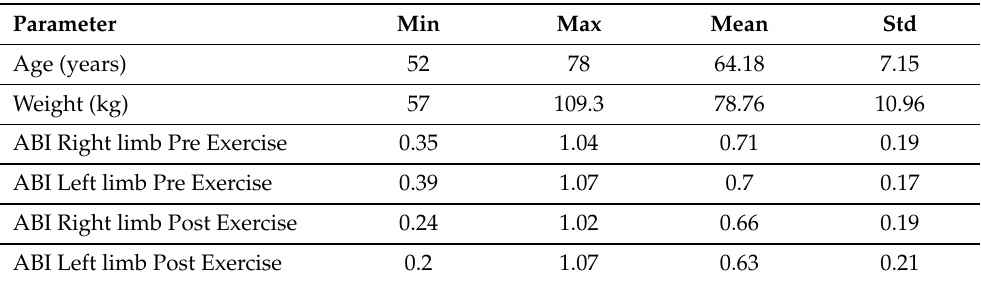
Table 1. Description of